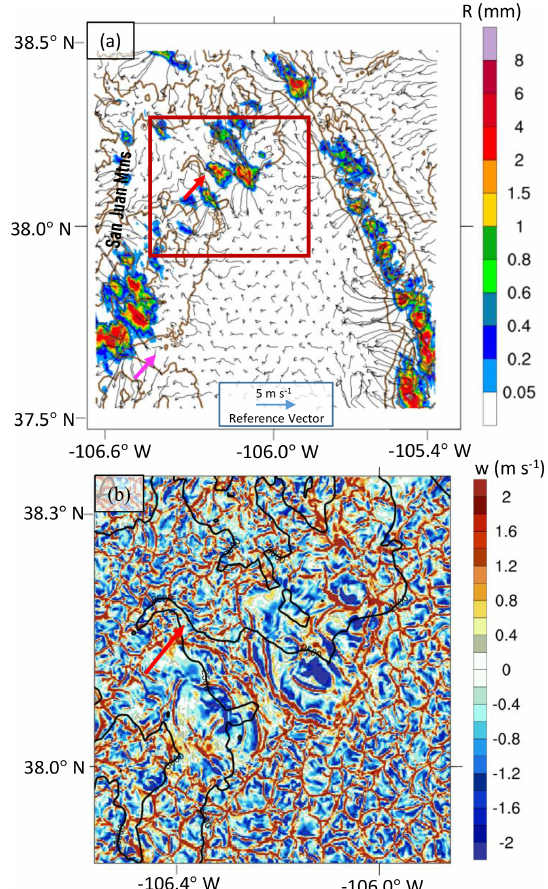
Figure 4. Simulated (a) 80m winds (direction and magnitude) and 1h precipitation accumulation ( R , color contours) and (b) vertical velocities ( w ) at 180ma.g.l. from WRF LES valid at 14:30MDT on 17 July 2018. Region shown in panel (b) is a 40km box outlined in panel (a) which is centered on SAG Airport. Terrain contours are also given for reference in both panels. Saguache Canyon is iden- tified with the red arrow in panels (a) and (b) , while Rio Grande Canyon is pointed out with the magenta arrow in panel (a)